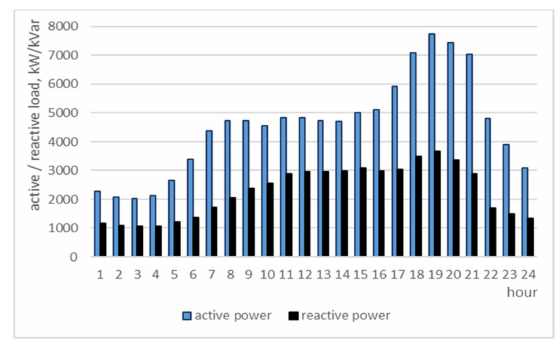
Figure 21. The active and reactive load profiles of the 215-bus network—hourly values.